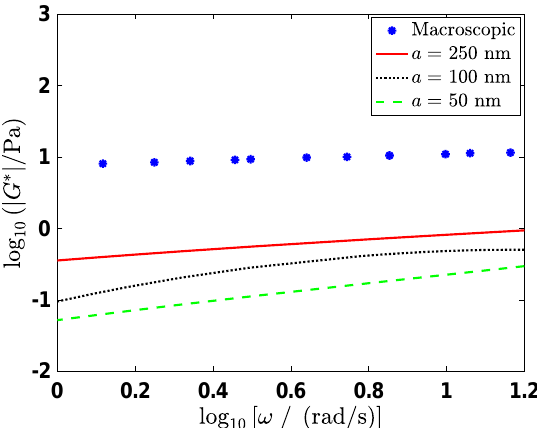
Figure 1: Comparison of | G * | between macroscopic and microscopic rheology from Dawson et al. [15]. A torsional rheometer with cone- and-plate geometry was used. Multiple particle tracking was used for the